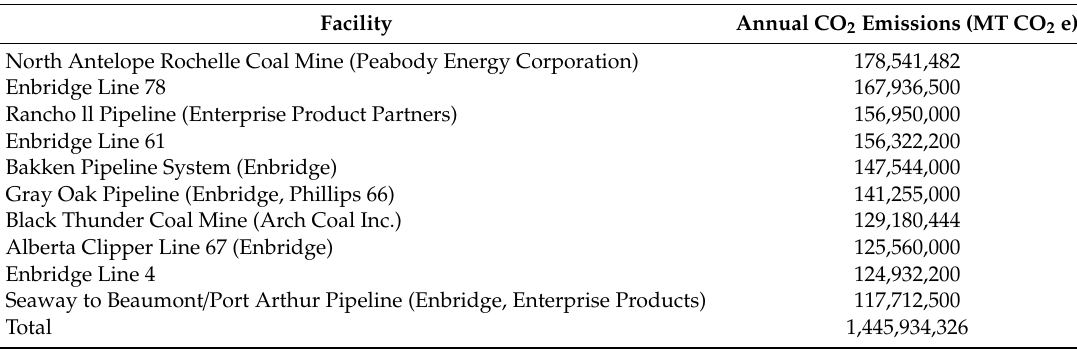
Table A4. Overall Top 10 CO 2 Emission Point-Sources Across All Fossil-Fuel Industries in U.S.